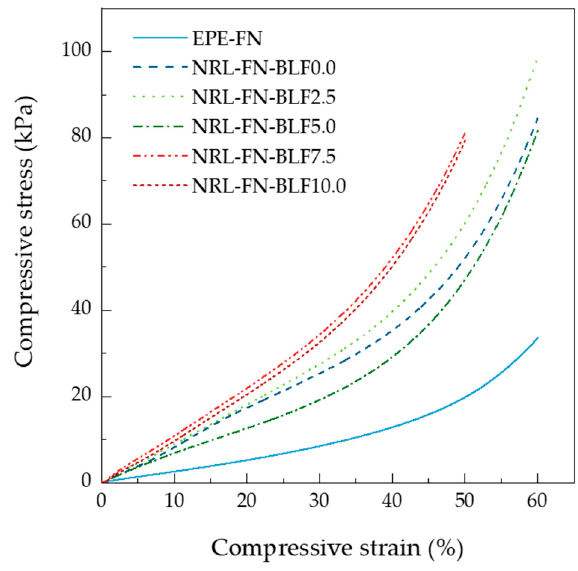
Figure 11. Stress–strain curve of the cushion